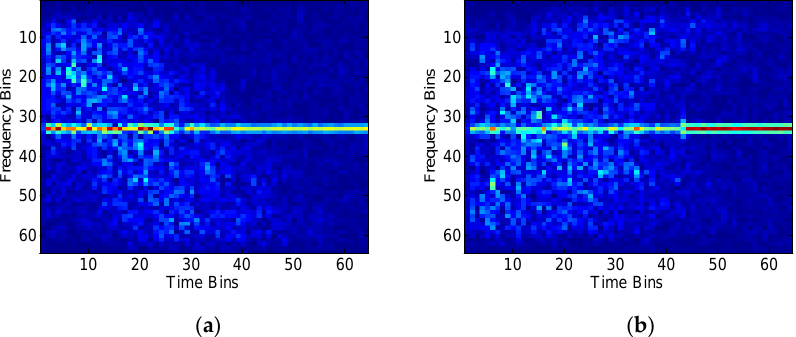
Figure 11. The representation of the (a) 500th and (b) 1000th measured NBI-contaminated echoes in the time–frequency domain.